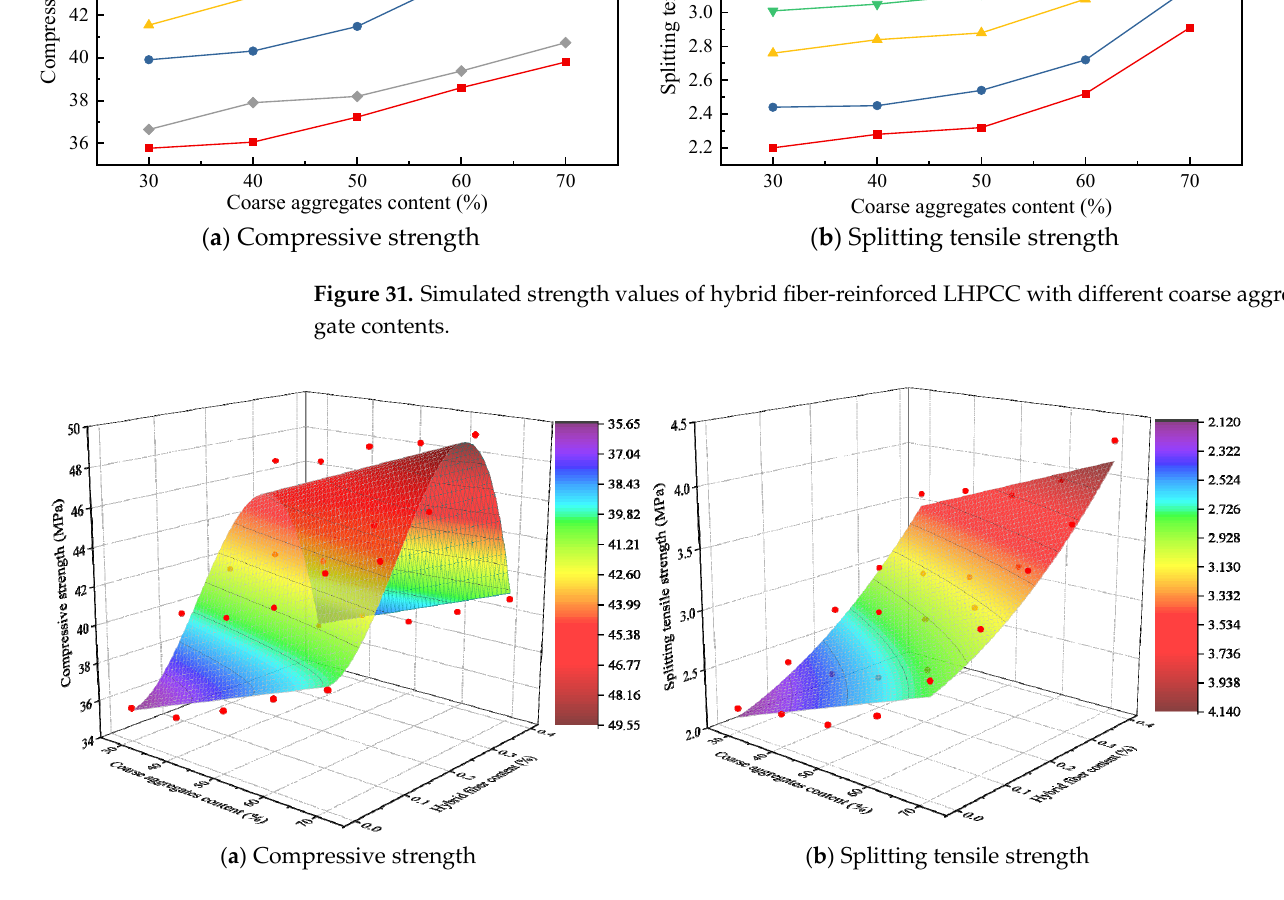
Figure 32. Non-linear surface fitting results for the effect of aggregate and hybrid fiber content on the strength of LHPCC. Figure 30 corresponds to the equation of compressive strength as shown in Equation (15).